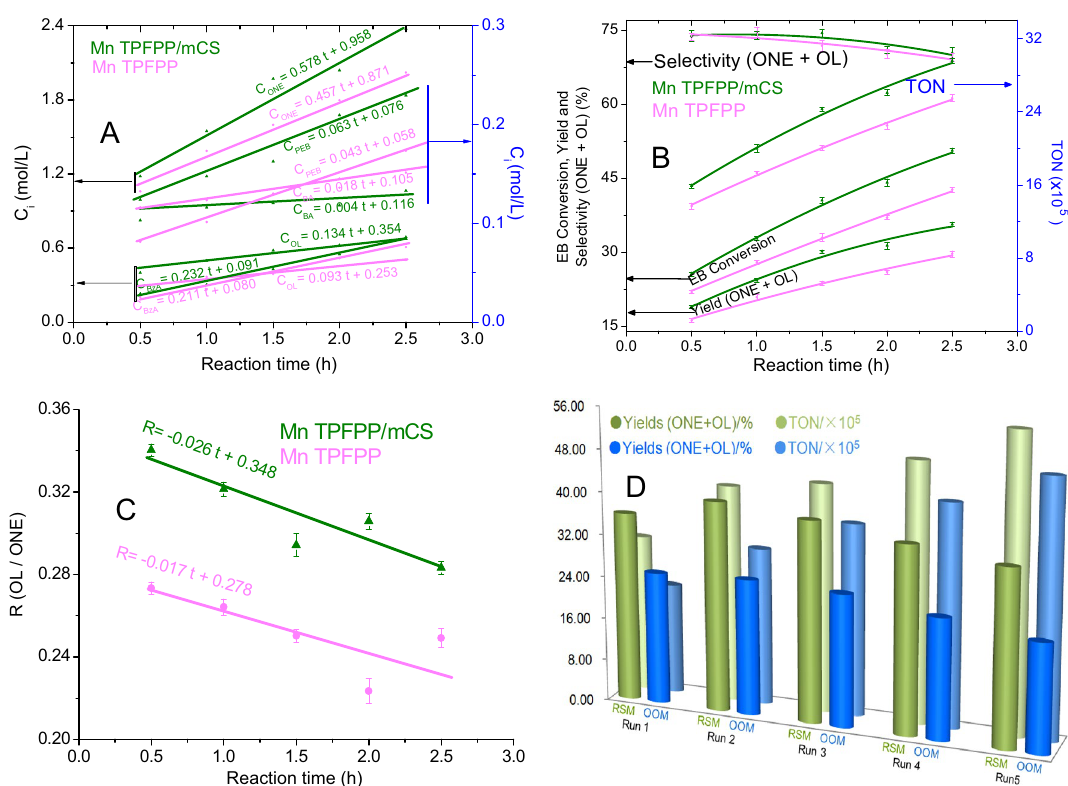
Figure 6. Catalytic activity and efficiency of Mn TPFPP/mCS and Mn